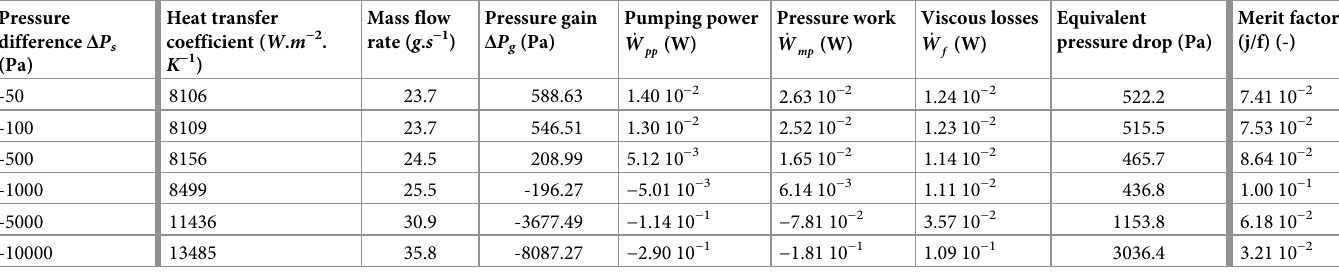
Table 3. Performances of the dynamic corrugated heat exchanger for an amplitude of 89%. Pressure Heat transfer difference Δ P coefficient ( W . m − 2 s (Pa)